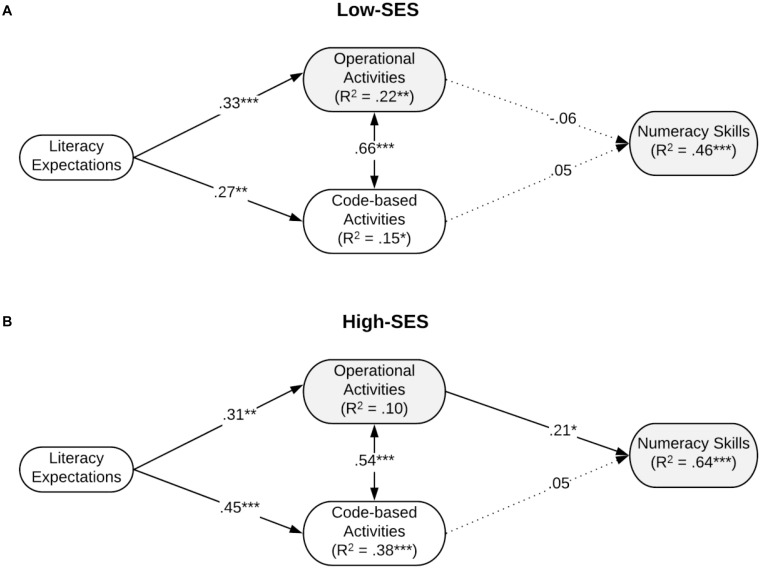
Final path model shows relations among literacy expectations, home learning activities, and children’s outcome for low SES group (A: n = 99) and high SES group (B: n = 74) controlling for child’s age. The R2 values shown include variance predicted by the control measure. The numbers on the arrows are the standardized coefficients. Dashed lines present no significant paths. *p < 0.05, **p < 0.01, and ***p < 0.001.